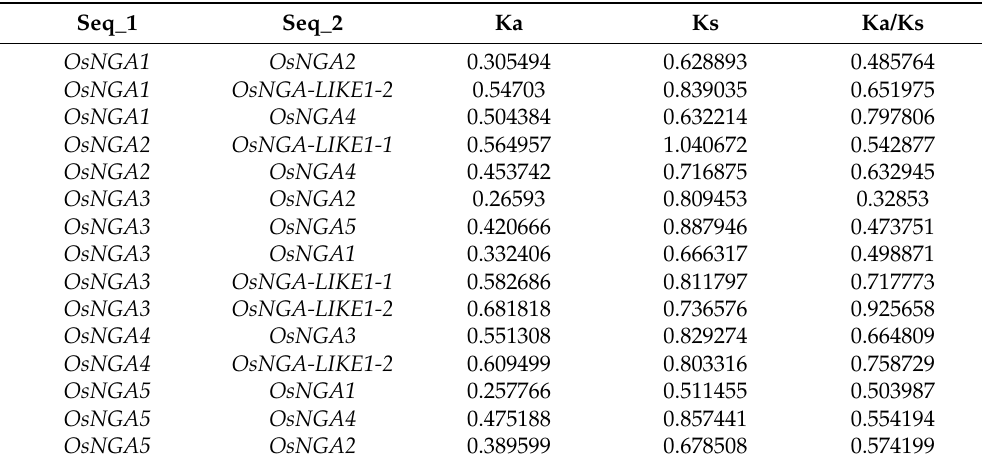
Table 4. Synonymous and non-synonymous substitutions in Poaceae members (rice, sorghum, and